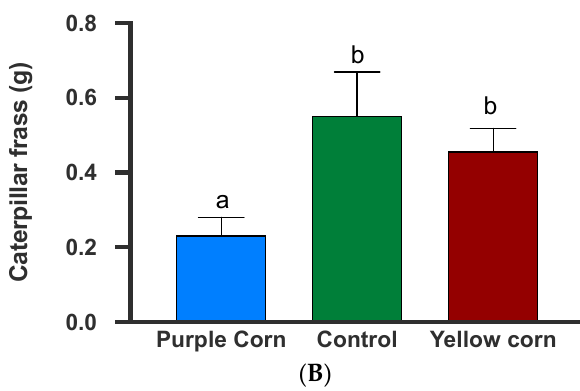
Figure 8 Mean larval mass gain after spray (A) and larval frass collected after two sprays (B) among Figure 8. Mean larval mass gain after spray ( A ) and larval frass collected after two sprays ( B ) among different treatments. Means followed by same letters are not significantly different (Kruskal–Wallis di ff erent treatments. Means followed by same letters are not significantly di ff erent (Kruskal–Wallis tests, Dunn’s multiple comparison test, p < 0.05). tests, Dunn’s multiple comparison test, p <